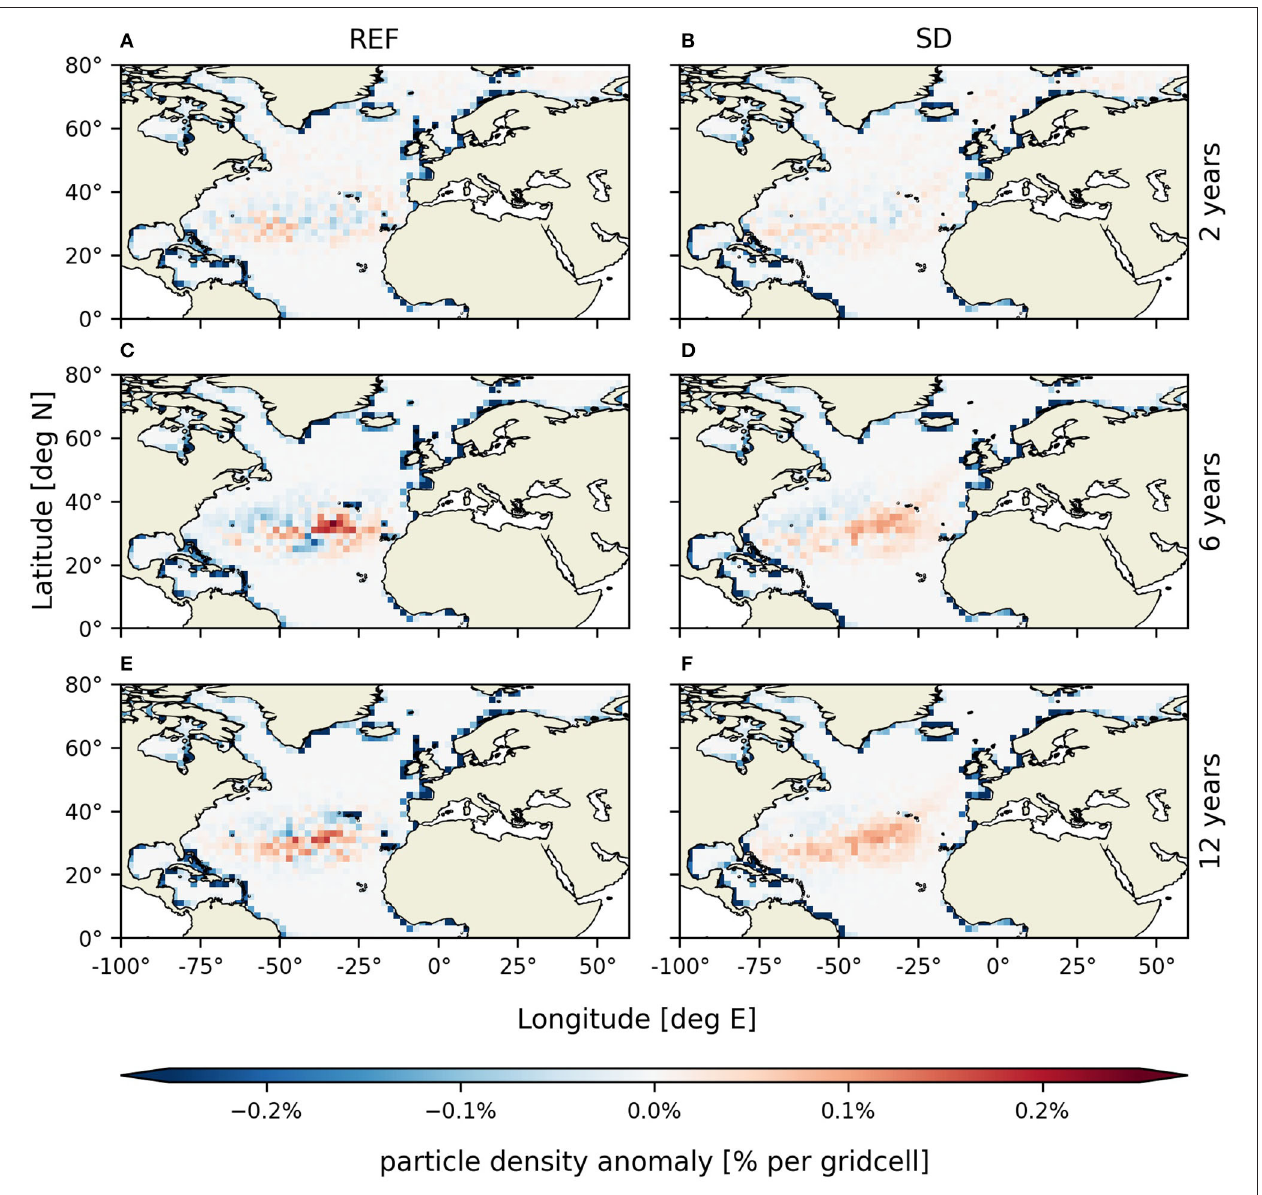
FIGURE 2 | Anomaly between matrix and model predictions (= matrix - model). The adjacency matrix is calculated with a 1 t of 1 year and predictions are calculated from the same initial condition as the PTMs. Colours represent the difference in particle concentration per 2 ◦ × 2 ◦ bin, in percentage, relative to the total number of particles. The anomaly is shown at snapshots of 2, 6, and 12 years for both PTM-REF (A,C,E) and PTM-SD (B,D,F)